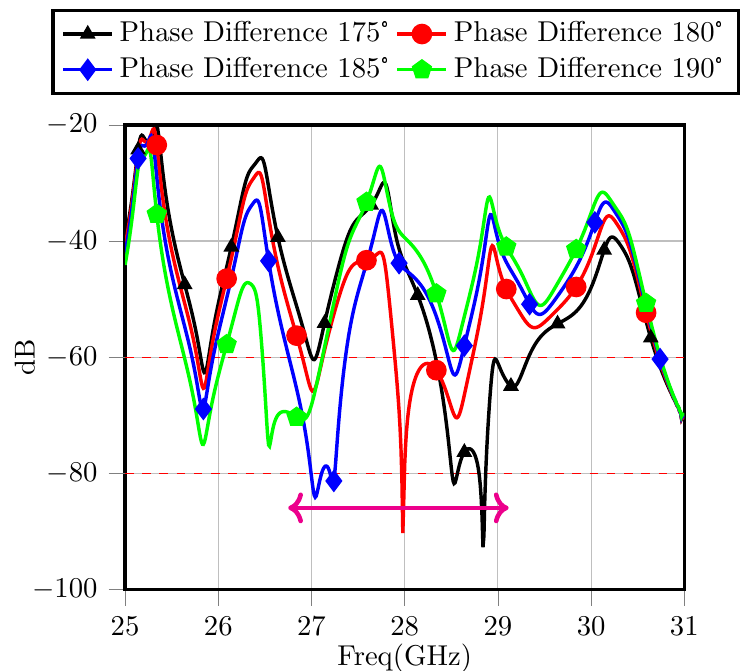
Figure 12. SiC dependence on phase shift in the SIW integrated antenna.